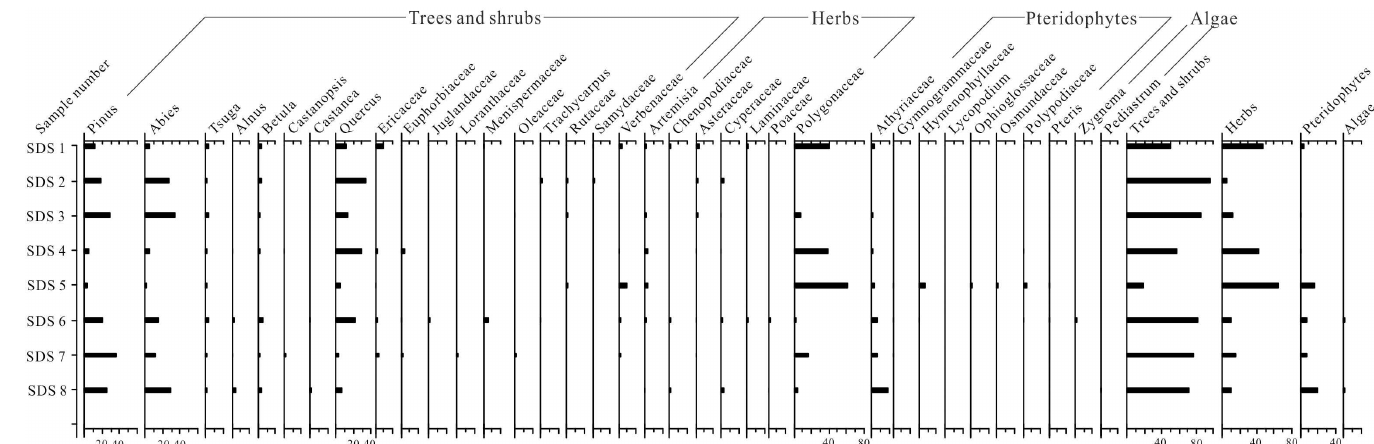
Fig 3. Pollen percentage diagram of major palynomorphs for Shudu Lake surface samples,